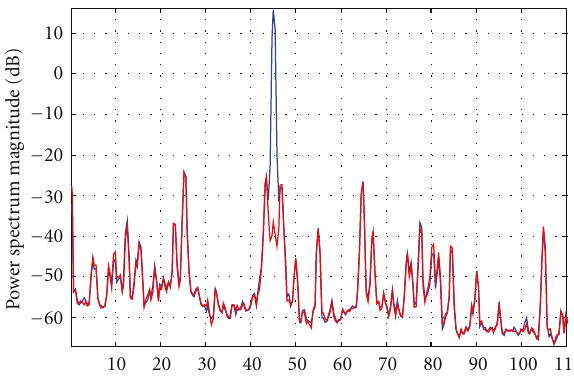
Figure 22: Power spectrum before (blue) and after (red) Wiener filter (fed driven machine).